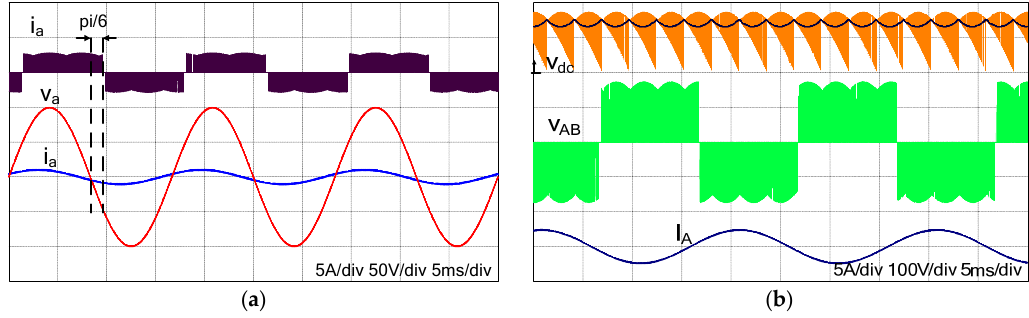
Figure 11. ( a ) Input waveforms; and ( b ) DC-link voltage and output waveforms with the proposed method at m = 0.35 and f out = 50 Hz.